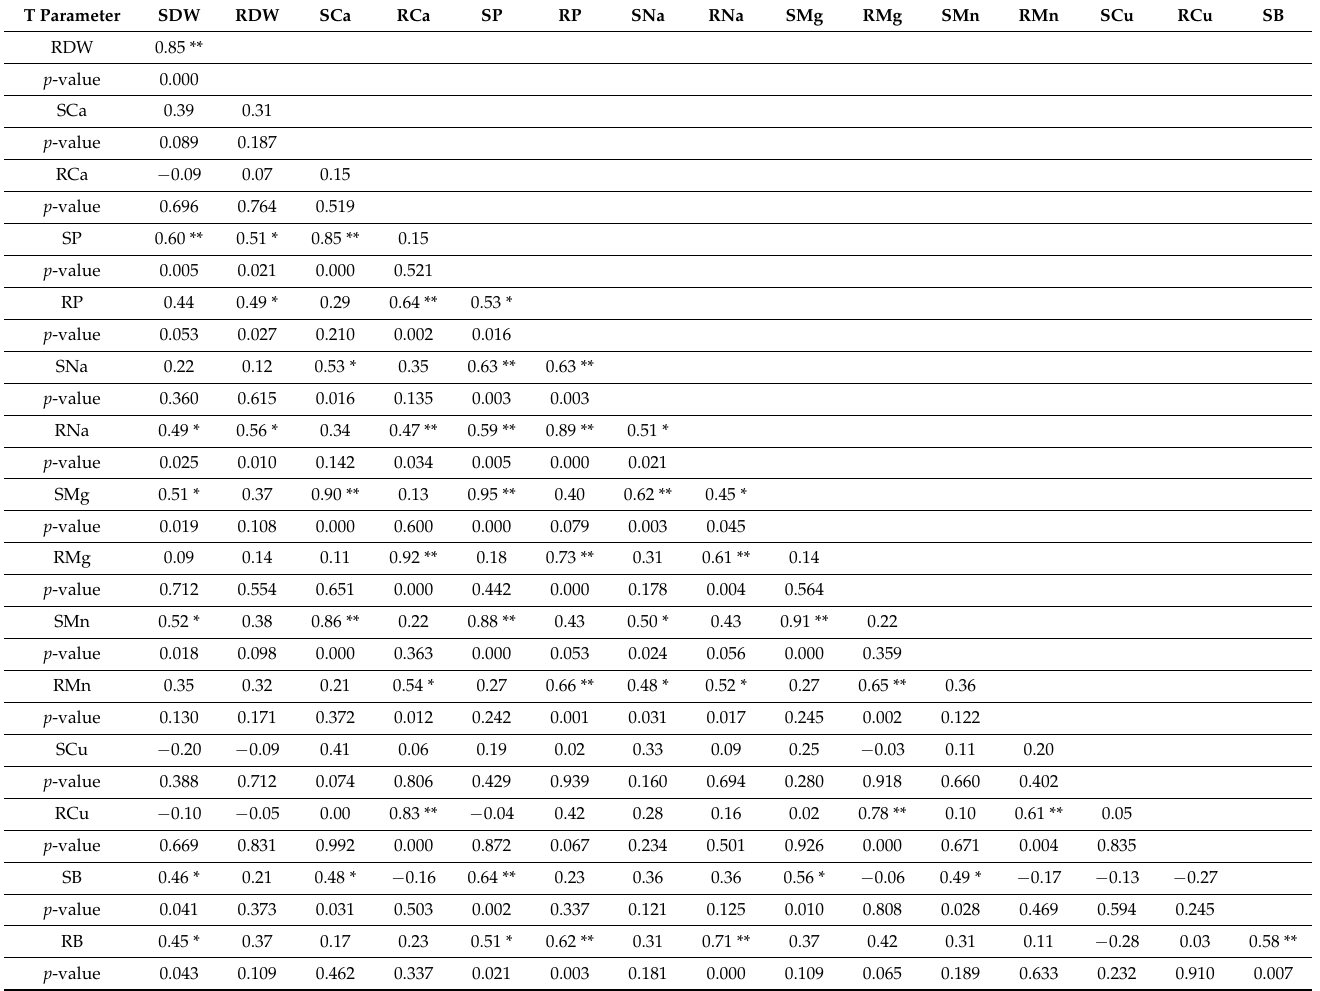
Table 4. The association between the relative changes in the elements and root-shoot dry weight in high B treatment (10 mM) as compared to control using Pearson correlation-based correlation analysis. The associations with p < 0.05 and p < 0.01 were accepted to be significant (*) and highly significant (**),